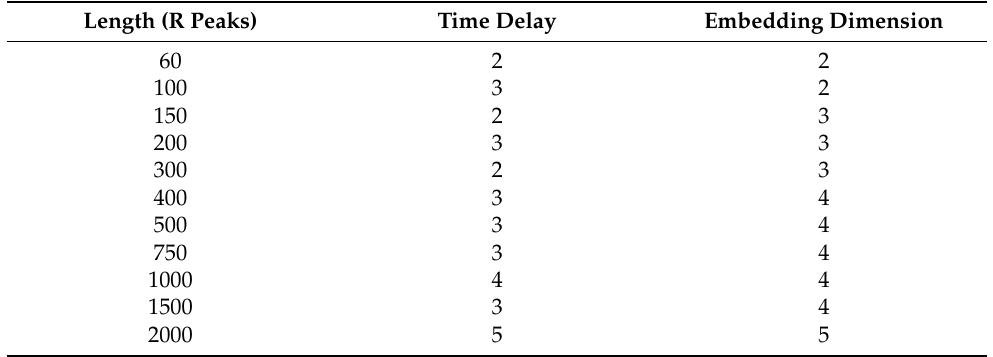
Table 1. The values of time delay and embedding dimension used in different data lengths. Length (R Peaks) Time Delay Embedding